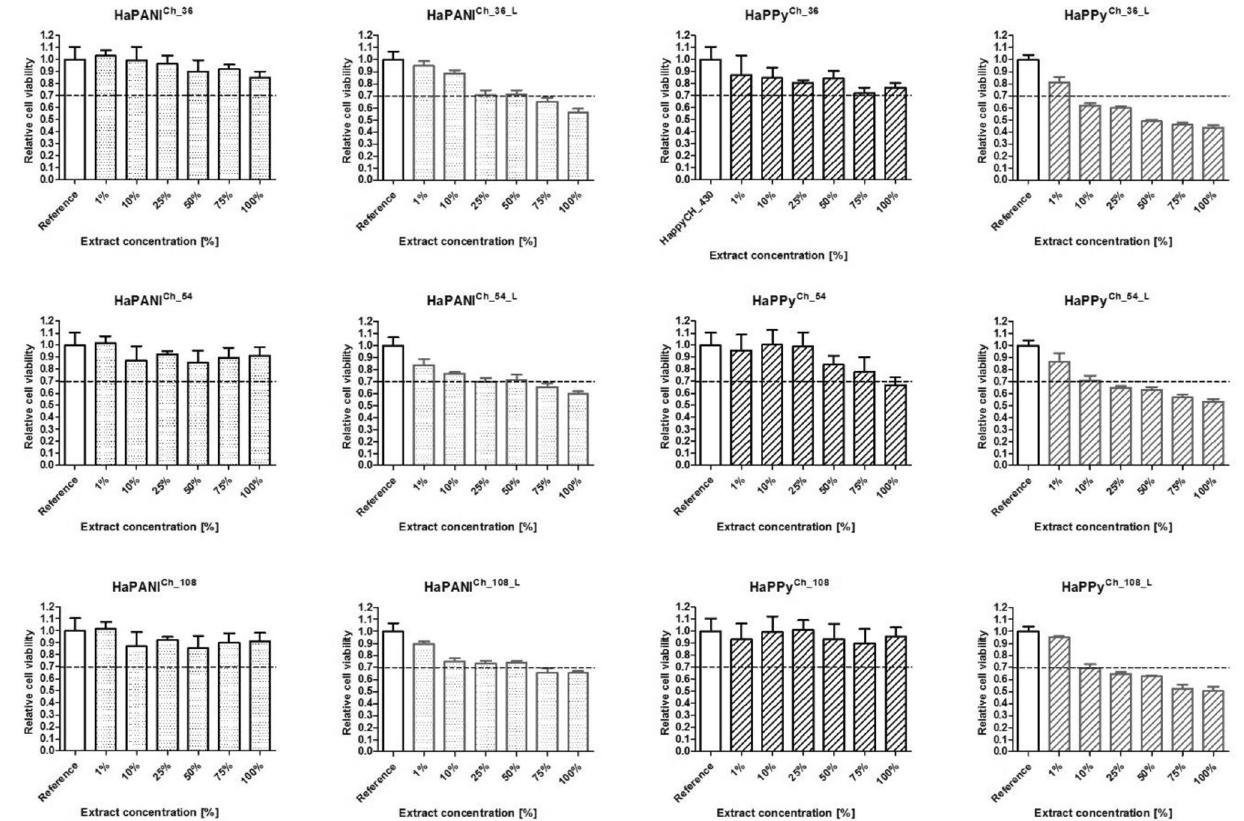
Figure 7. The cytotoxicity of chemically crosslinked scaffolds. According to ISO standard 10993, a decrease in viability to below 70% of the reference corresponds to a cytotoxic effect on the part of the tested materials. Here, the dashed line shows the threshold of cytotoxicity. All tests were conducted in quadruplicates within three repetitions. The average viability with its standard deviation are